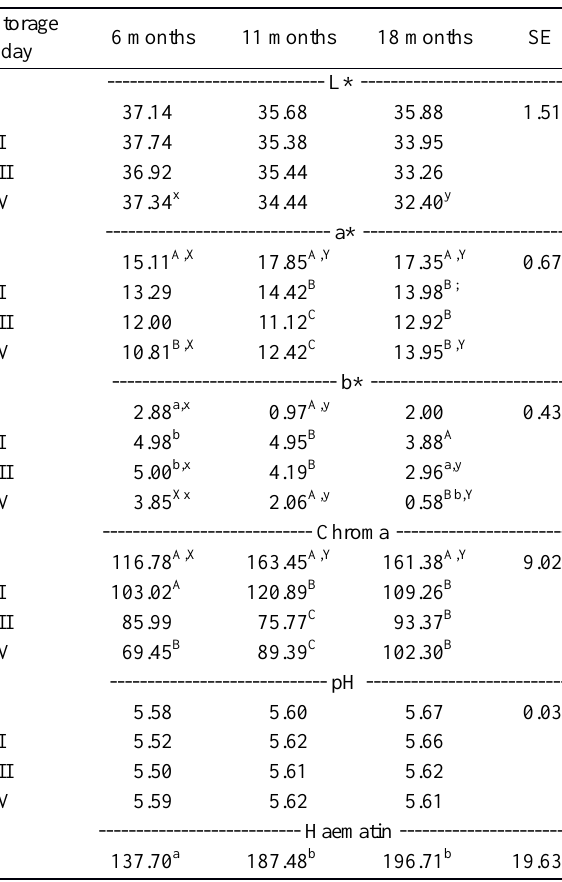
Table 1. Influence of slaughtering age on colorimetric parameters of not-renewed cutting surface (NRCS), pH and haematin (ppm) during the four post-thawing days (Least square means  standard error)